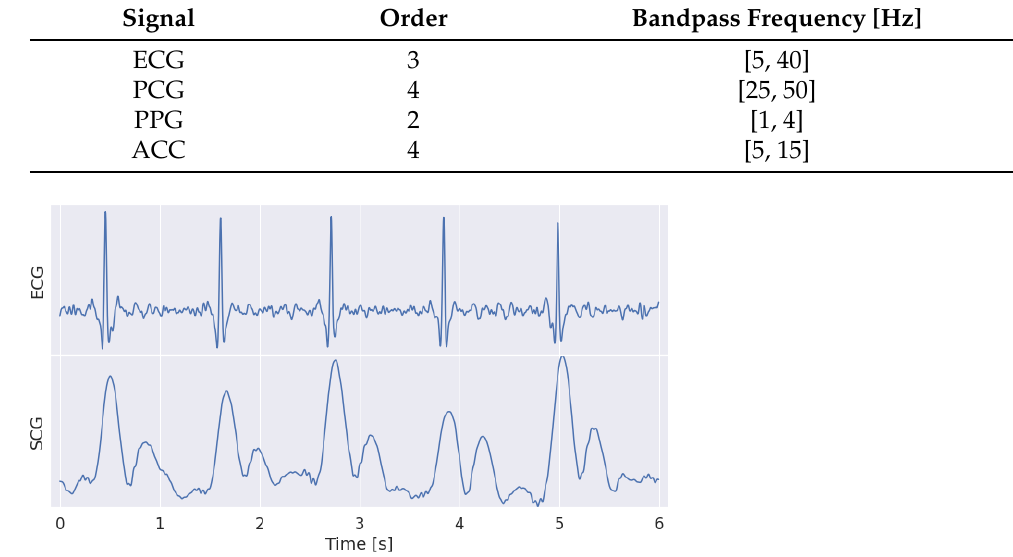
Figure 2. Comparison of ECG and SCG signals. As expected, the envelop of the acceleration signal highlights the two patterns, the opening and the closure of the aortic valve, in the SCG waveform. Coherently, the R wave in the ECG slightly anticipate the opening of the aortic